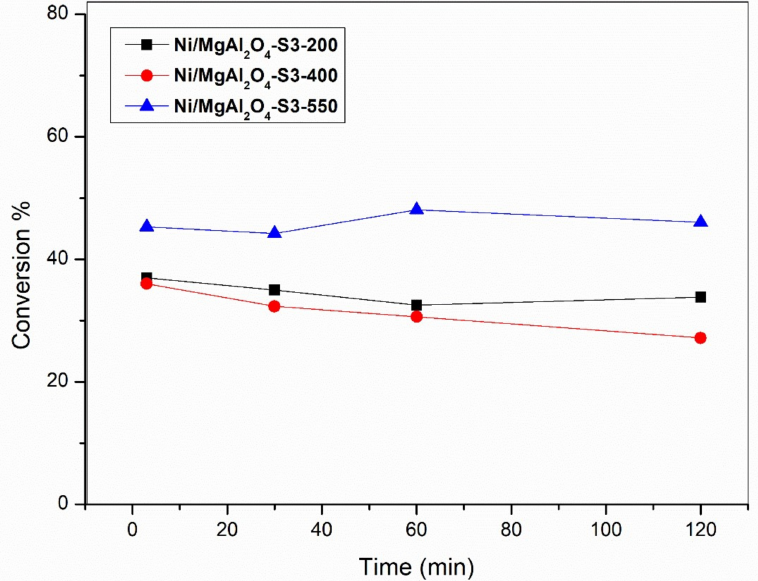
Figure 18. Conversion % of Ni/MgAl 2 O 4 sulfided with DMSO at 200 ◦ C (black square), 400 ◦ C (red circle) and 550 ◦ C (blue